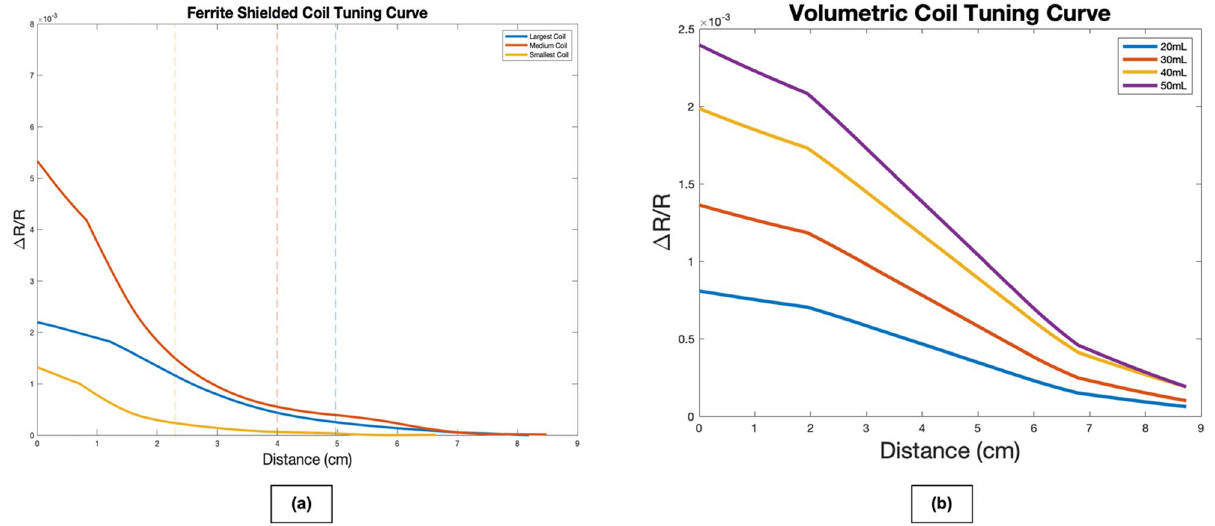
(cid:31) R R =0), which was